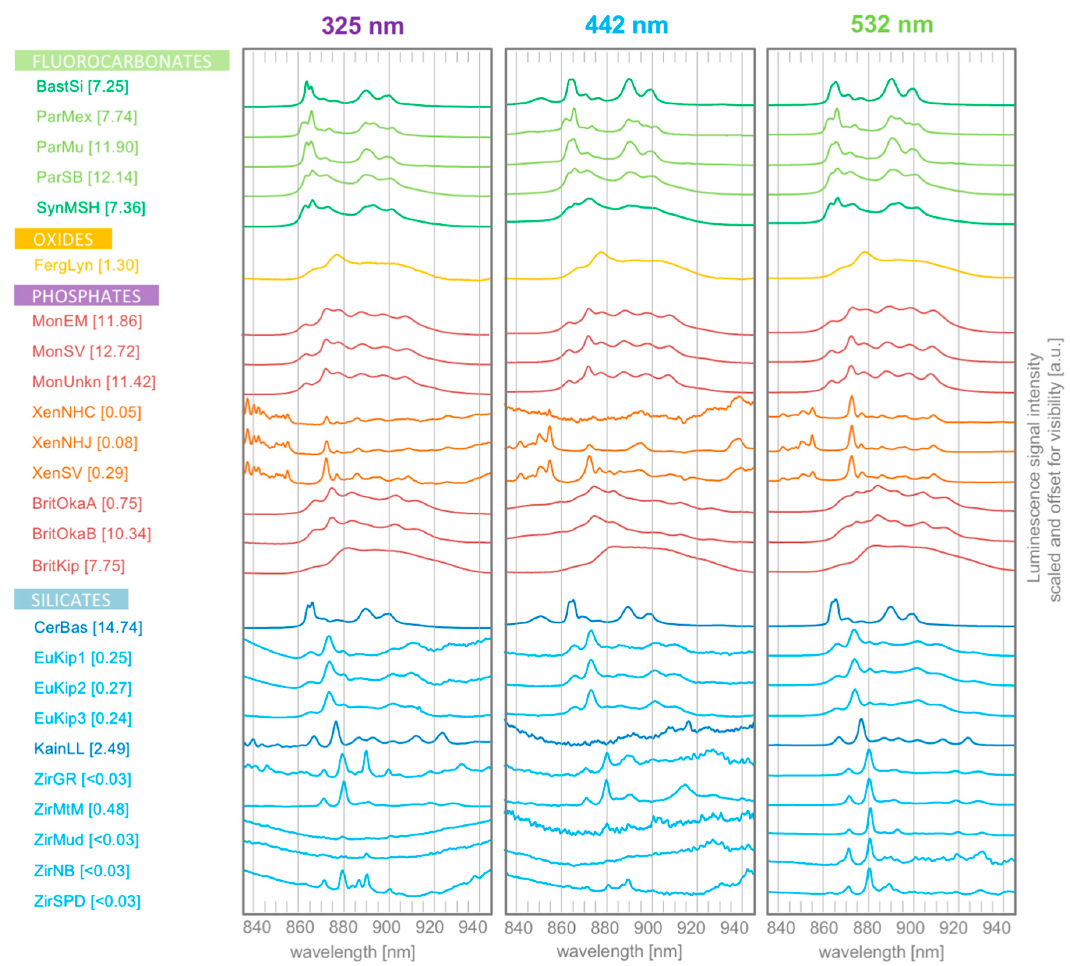
Figure 7. Variability of Stark-level emission peaks for the literature reported Nd 3+ feature centre wavelength of 890 nm [34,53] for different samples and excitation wavelengths. EMPA derived Nd 2 O 3 -concentrations are given in squared brackets in wt.%. Excitation wavelengths are indicated on top of each plot group.